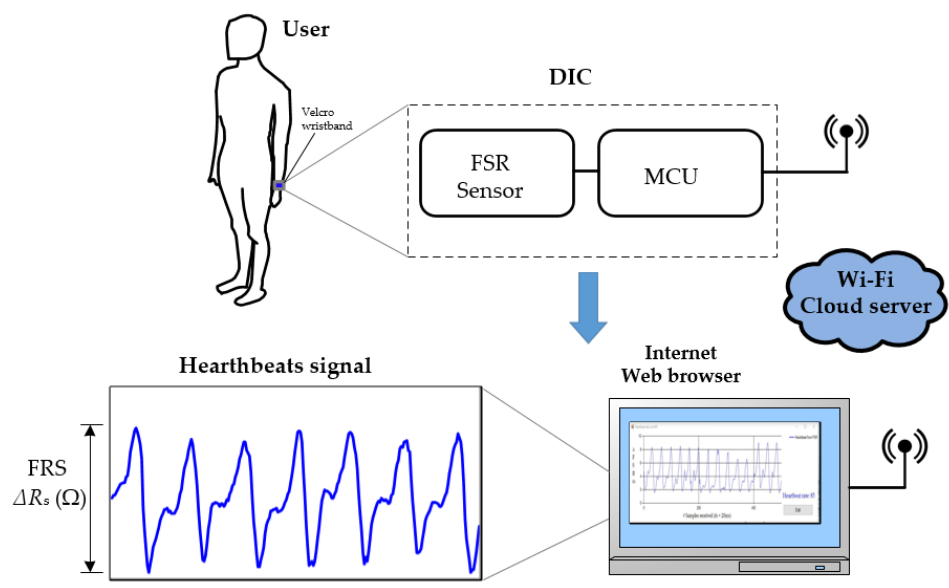
Figure 1. Wearable sensing approach for remote heart rate monitoring.